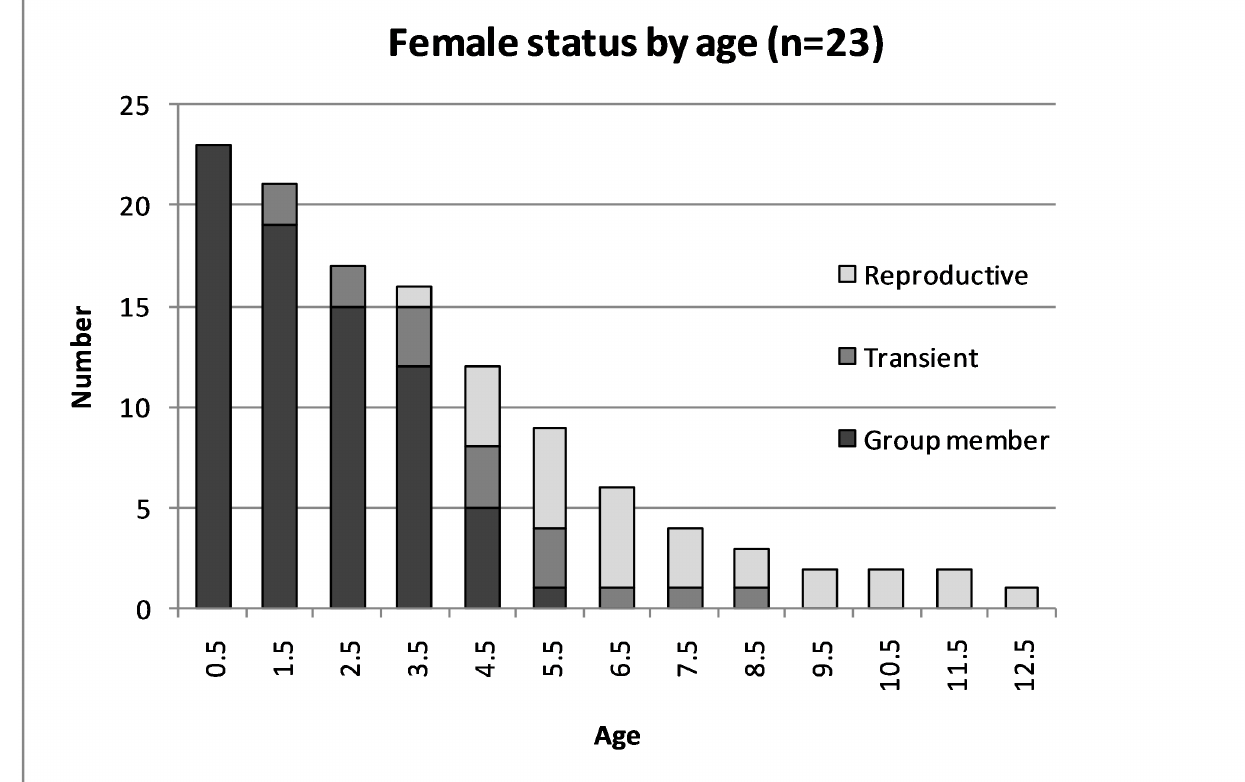
Figure 9. Female status (R - reproductive group member, T - transient, G - non-breeding group member) by age age class (n=23).